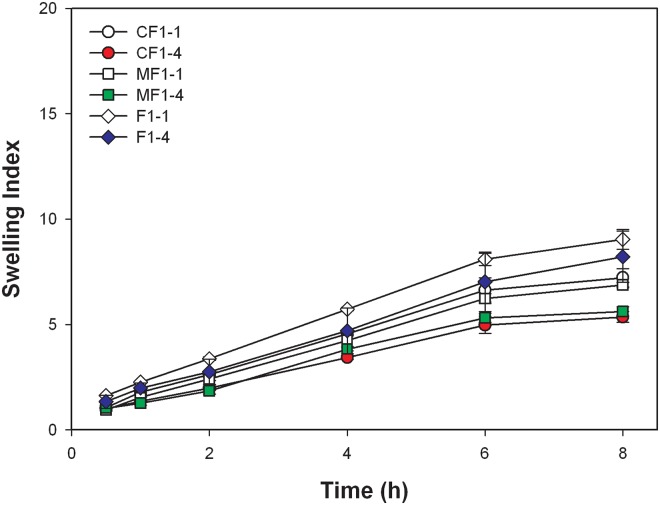
Swelling indexes of F1–1, F1–4, and F1–1 and F1–4 incorporated with metformin and ciprofloxacin in simulated gastric solution.